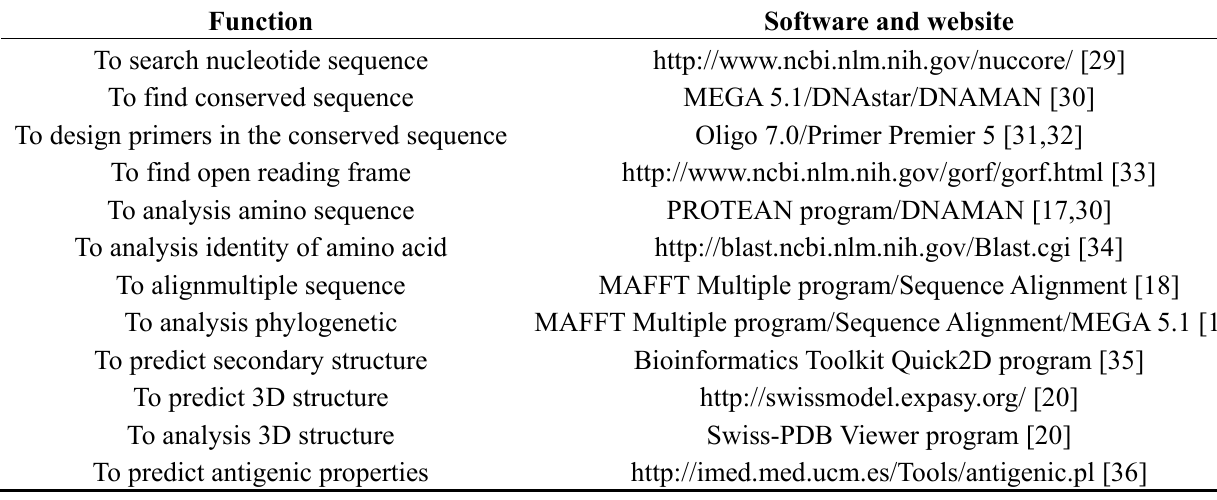
Table 5. Brief introduction of the softwares and